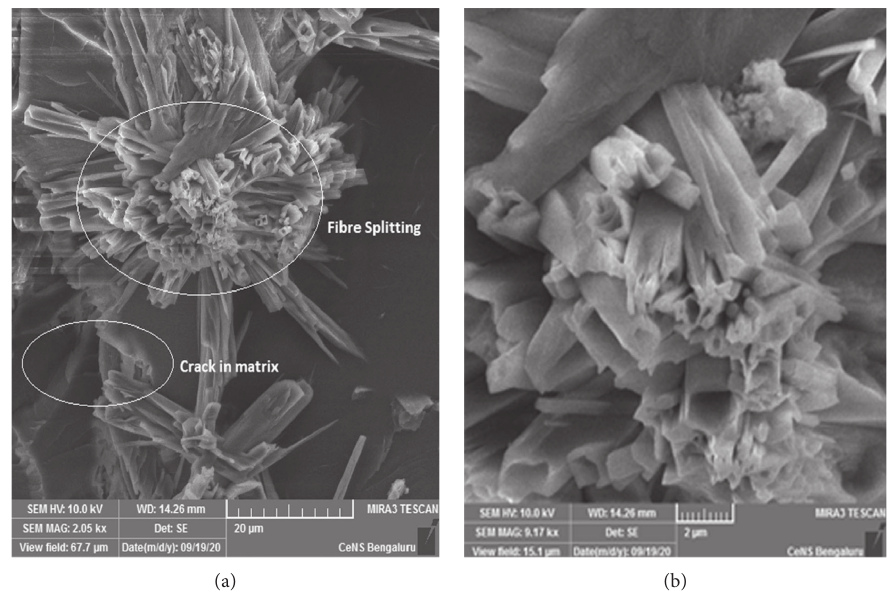
Figure 4: SEM of used jute epoxy composite with 6wt.% of graphite filler in the matrix.